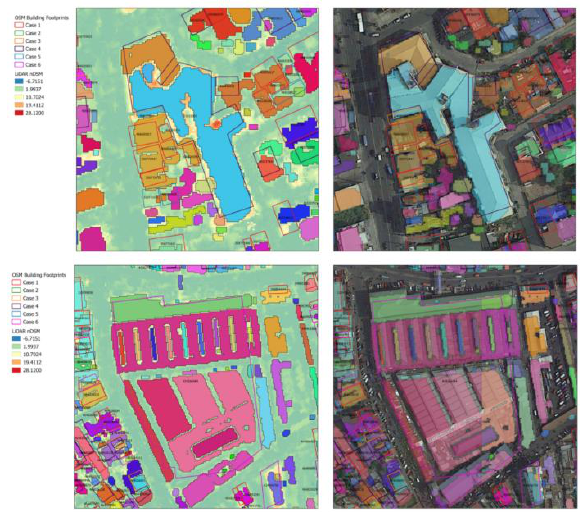
Figure 6. Areas showing over-segmentation of detected nDSM buildings.